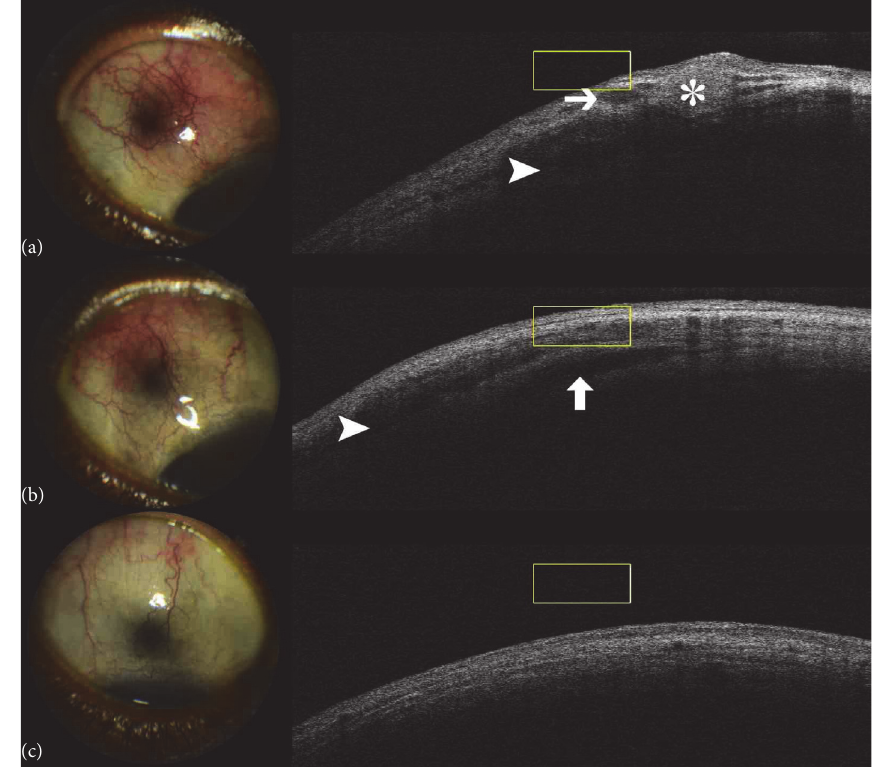
Figure 2: (a) RE, superotemporal sector hyperaemia, episcleral nodule (asterisk), subepiscleral oedema (arrow), and scleral oedema (arrowhead). (b) RE, after antituberculous chemotherapy initiation, hyperaemia subsided and nodules have disappeared but subepiscleral (arrowhead)andscleraloedemapersist(arrow).(c)RE,afterterminationoftherapy,nohyperaemiaispresent,andnooedemacanbedetected in the scleral or episcleral layers adjacent to previously detectable